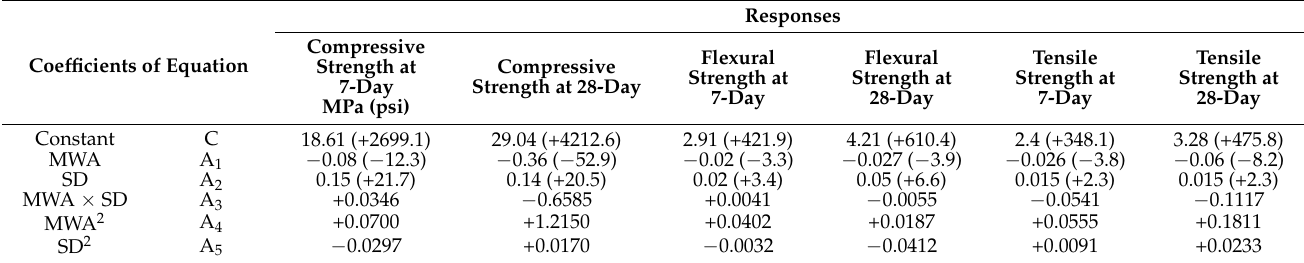
Table 9. Coefficients of the equation to predict responses.